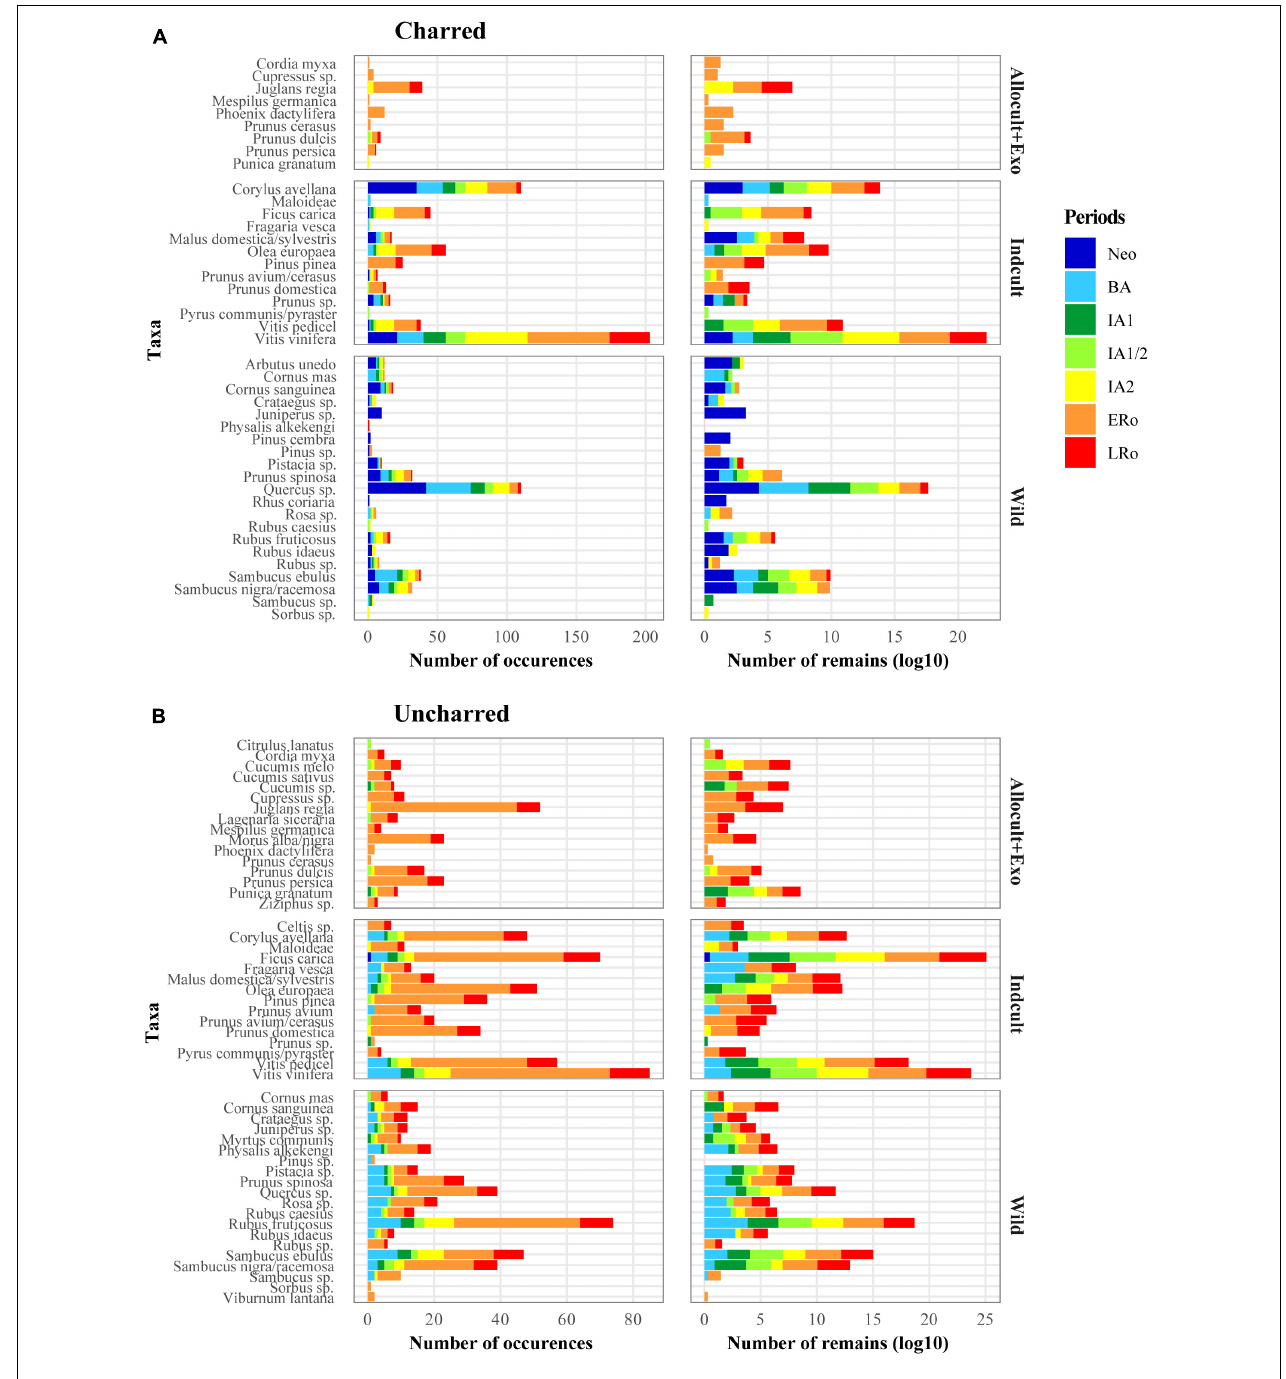
FIGURE 2 | Bar plots showing the overall representation of fruit taxa within (A) charred and (B) uncharred plant remains in relation to broad fruit categories (Exotic + Allocult, Indcult, Wild) and to cultural periods. Two methods of representation are used: number of occurrences of taxa in all sites, log-transformed (log10) raw counts of fruits in all the